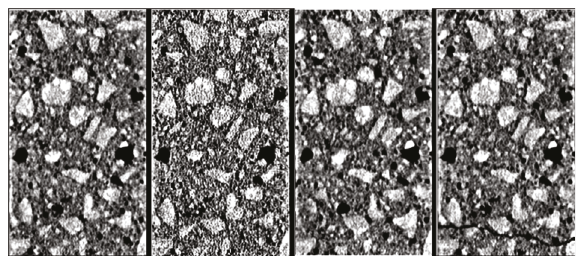
Figure 25: CT scan sectional